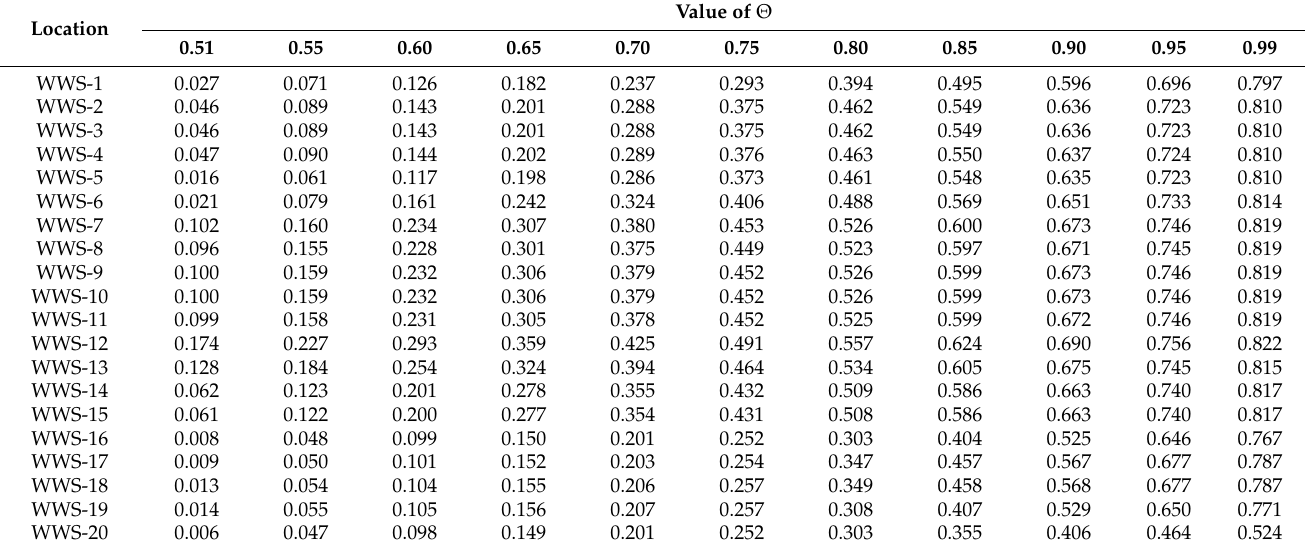
Table A2. The results of the B-DEA model.